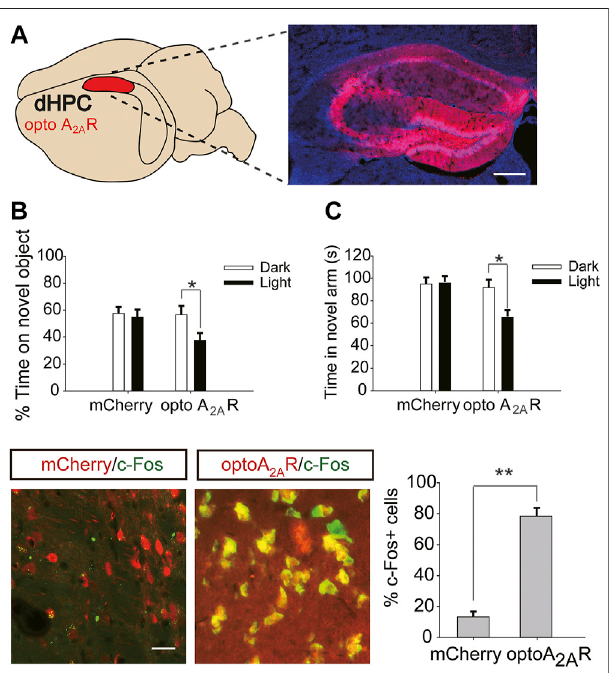
FIGURE 6 | Targeted expression and light activation of optoA 2A R in the dHPC prevents the memory improvement caused by caffeine consumption. (A) Selected expression of AAV-optoA 2A R or AAV-mCherry in the dHPC (Scale bar = 500 μ m). (B) Behavior of mice in the Novel Object Recognition (NOR) test ( n = 7 mice per group). C Behavior of the four groups of mice in the Y-maze test ( n = 7 mice per group). Light stimulation of opto- A 2A RinthedHPCincreasedthetimespentexploringanovelobjectduringthe testing trial (B; * p < .05 using a two-way ANOVA followed by Bonferroni post hoc t-test) and the time spent in the novel arm during the retrieval phase (C; * p < .05 using a two-way ANOVA followed by Bonferroni post hoc t-test). (D) Light stimulation for 5 min induced c-Fos expression in optoA 2A R-positive cells but not in cells transfected with AAV-mCherry. Representative images (left)anddata(right)arepresented. n =27 fi eldspergroup(3 fi eldspersection, three sections per mouse, three mice per group); Scale bar = 50 μ m; ** p < .001, Student ’ s t-test comparing optoA2AR with mCherry. Data are presented as the mean ± SEM.